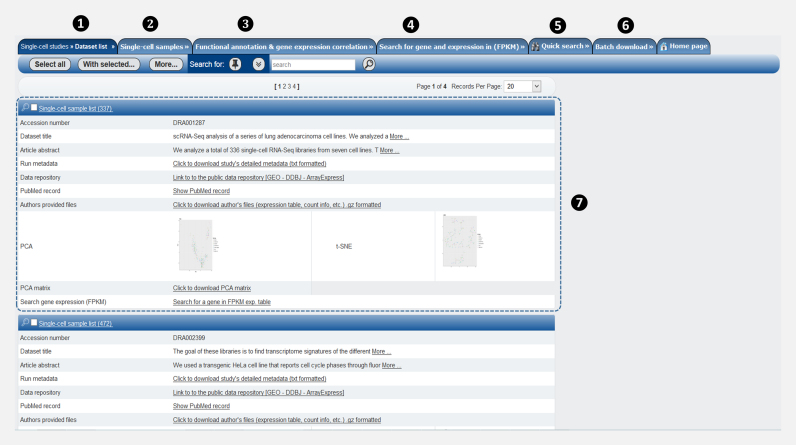
Single-cell transcriptomics dataset view. The figure shows the main elements of the single-cell transcriptomics dataset view. In the main menu bar, (1)–(6). The single-cell studies view is the active tab (7). For each study, a summary of the total number of samples is shown at the top left corner of the rectangle. Several attributes and links are provided in addition to the PCA and t-SNE plots. We also provide the computed PCA matrix (PC computed in FPKM) for each dataset as a table for downloading from this view.